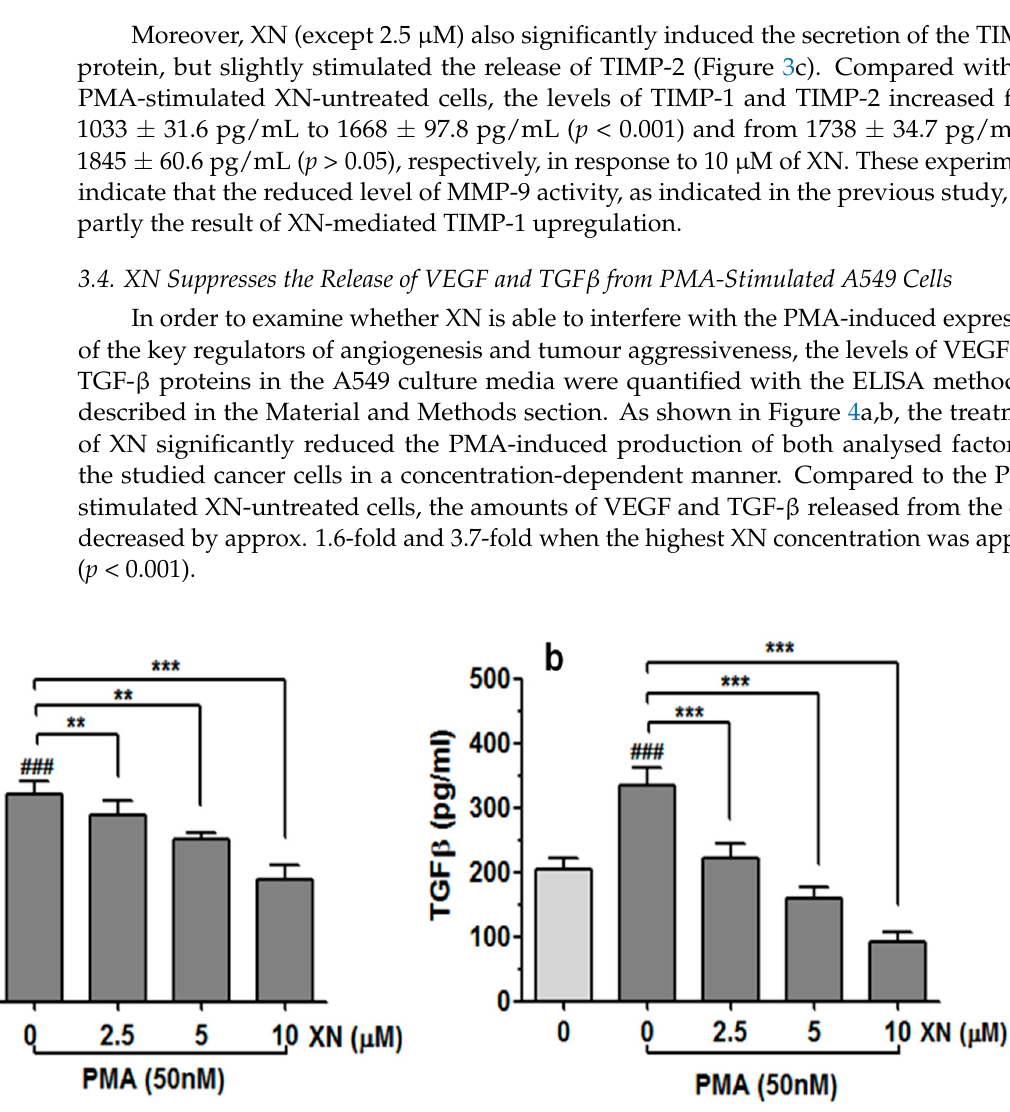
Figure 4. Effect of XN on VEGF and TGF- β release from PMA-stimulated cells. The A549 cells were pre-incubated with the indicated concentrations of XN for 4 h and then co-incubated in the presence of PMA for 24 h. Following the treatment, the concentration of VEGF ( a ) and TGF- β ( b ) in the supernatants was assessed using the ELISA assay. The results are presented as the mean ± SD of three independent experiments, ** p < 0.01, *** p < 0.001 in comparison to the PMA-only treatment, ### p < 0.001 in comparison to the non-stimulated cells; one-way ANOVA test.